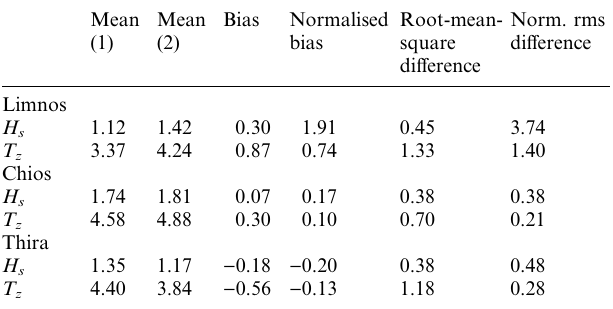
Table 13. Statistics for the storm August 1990, -40 points. Comparison of results from WAM and AUT wave model using